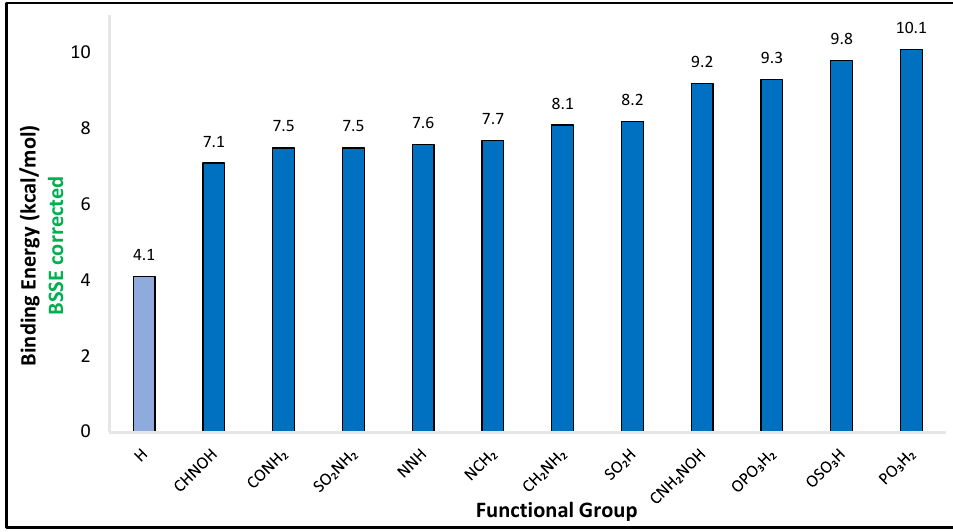
Figure 2. The binding energies of the 11 top-performing functionalized benzene together with the unfunctionalized one for comparison, calculated at the DSD–BLYP/def2–TZVPP level of theory, corrected for BSSE.